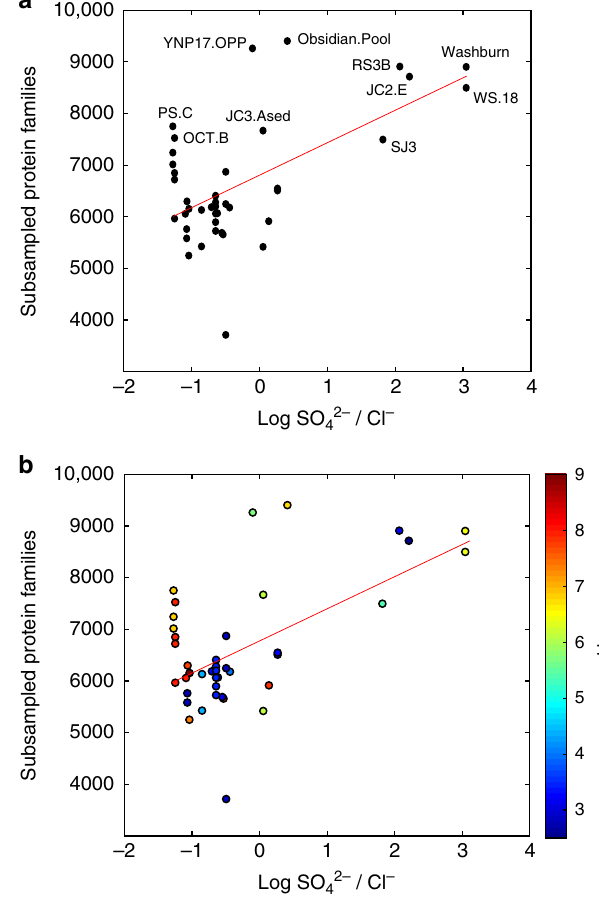
Fig. 5 Comparison of subsampled protein family diversity in chemosynthetic YNP hot spring metagenomes and inferred spring water origins. Protein subsampling was conducted on 10,000 randomly chosen protein homologs from each metagenome. The log transformed SO 4 2 − /Cl − ratio was calculated from publicly available data for each spring (Supplementary Data 10). Those metagenomes with higher protein family diversity than SJ3 after subsampling are indicated in a , with IDs corresponding to those provided in Supplementary Data 10. Red line